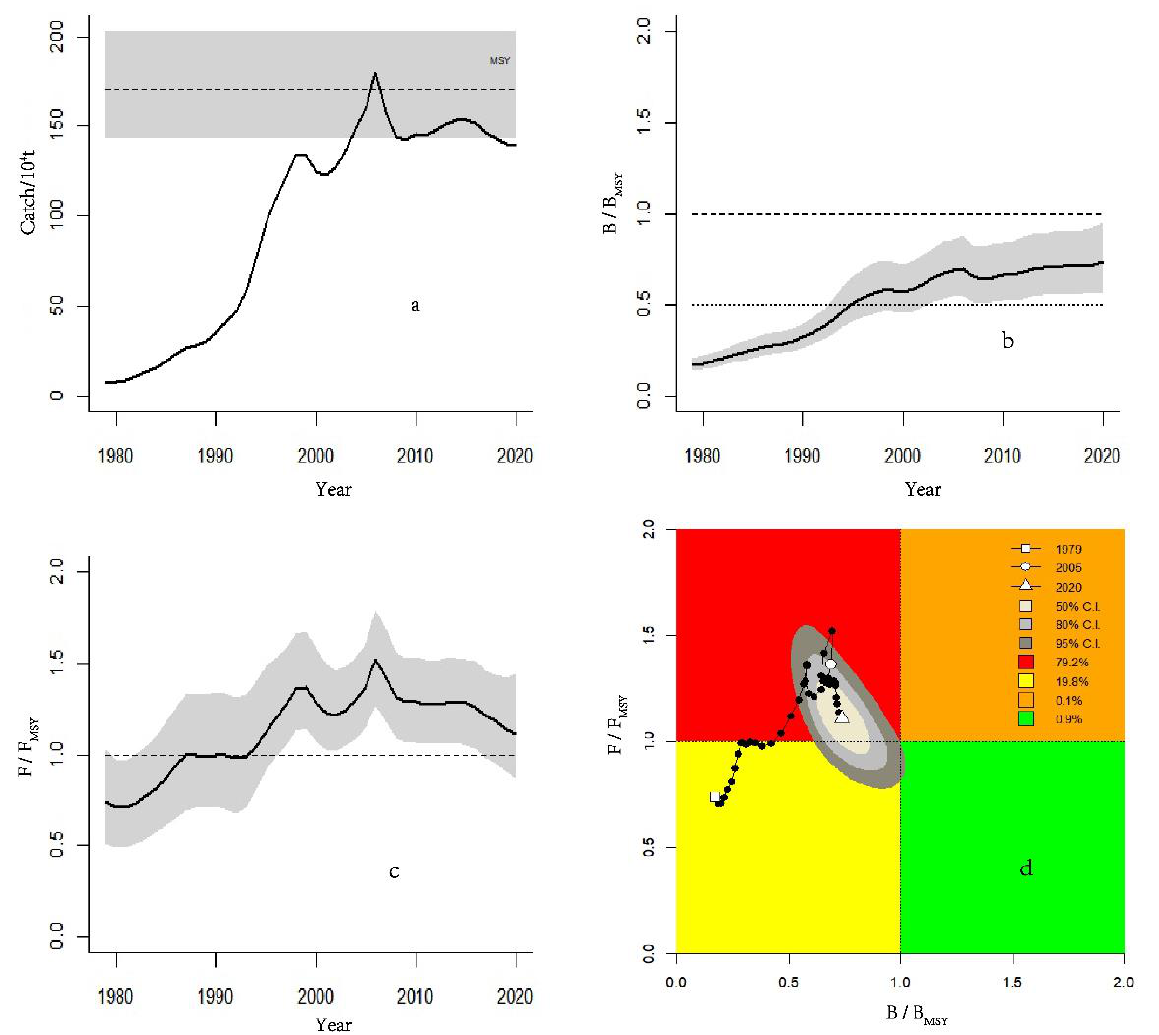
Figure 4. Results of stock assessment for Conger_ECS from BSM where ( a ) is the production, the horizontal broken line is the estimated value of MSY, and the grey region is the 95% confidence interval; ( b ) is the relative total biomass (B/B MSY ), the broken line of level 1 is the maximum sustainable biomass B MSY giving MSY, the dotted line of level 0.5 is 0.5B MSY , and the grey area is uncertainty; ( c ) is relative fishing pressure (F/F MSY ); and ( d ) is a Kobe plot between relative population biomass (B/B MSY ) and relative exploitation rate (F/F MSY ). The shaded areas are 50%, 80% and 95% confidence intervals (C.I.).